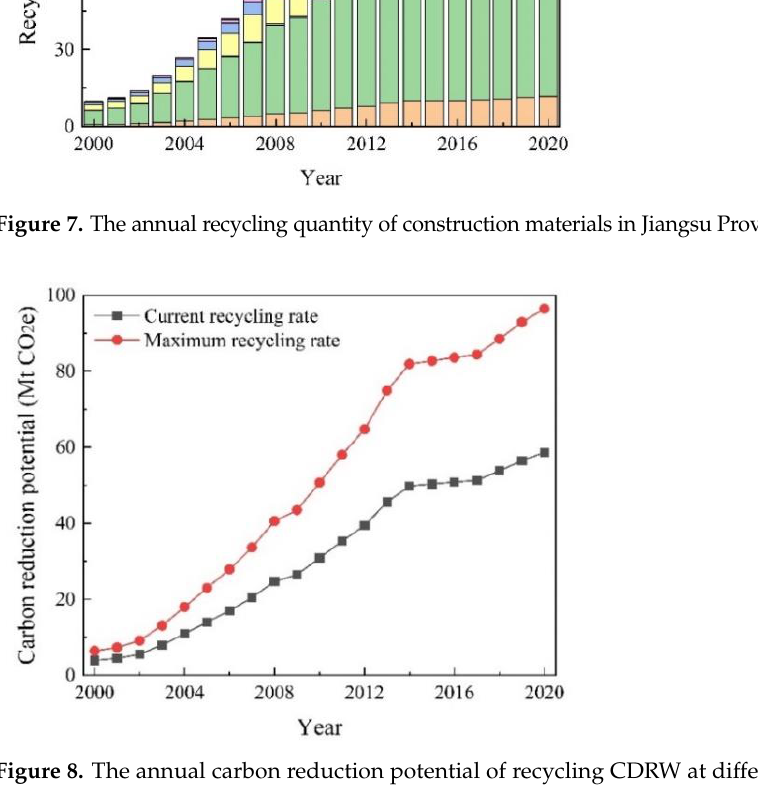
Table 5. Comparison of the carbon reduction potential of different recycling materials under two scenarios in Jiangsu Province in 2020.